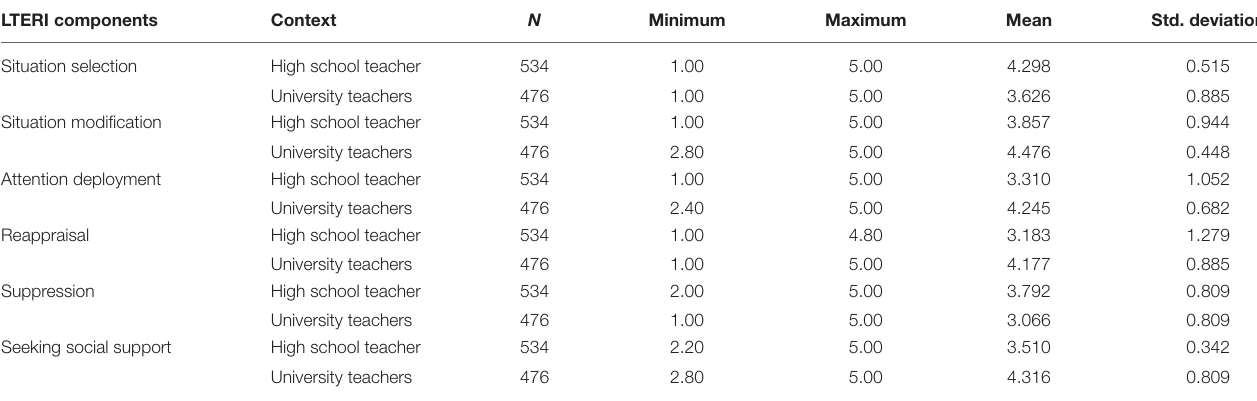
TABLE 8 | Descriptive statistics: emotion regulation sub-scales for EFL high school and university teachers. LTERI components